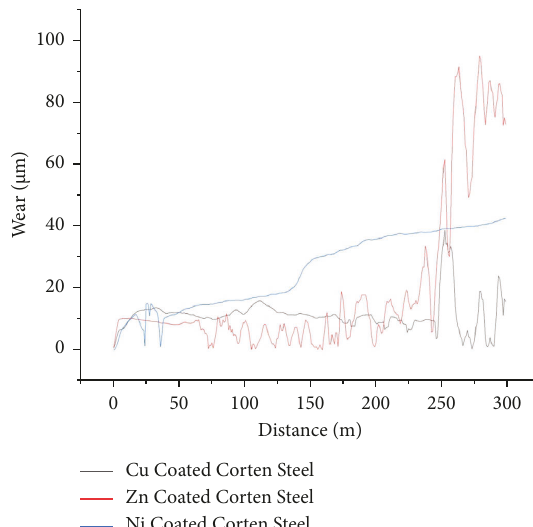
Figure 12: Wear rate of electroplated corten steel.